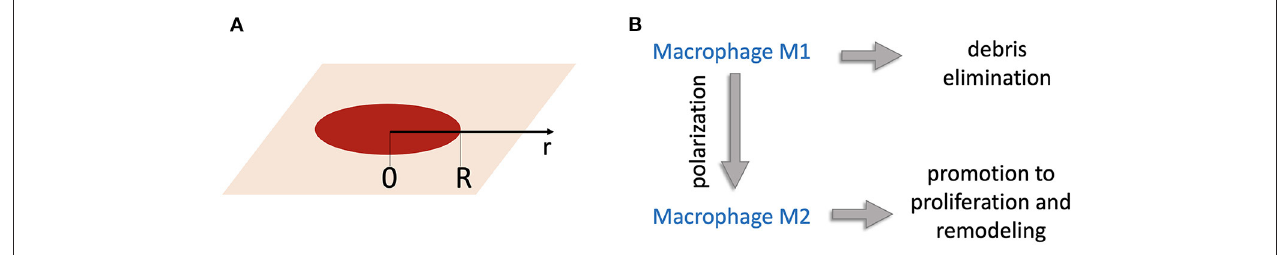
FIGURE 1 | (A) Geometry of the model: the r-axis is directed from the wound center; R is the wound radius. (B) Schematic of the model of wound healing. Wound debris D b attract M1 macrophages that remove debris. M1 macrophages become M2 macrophages, which induce production of temporary tissue C that helps new tissue N to